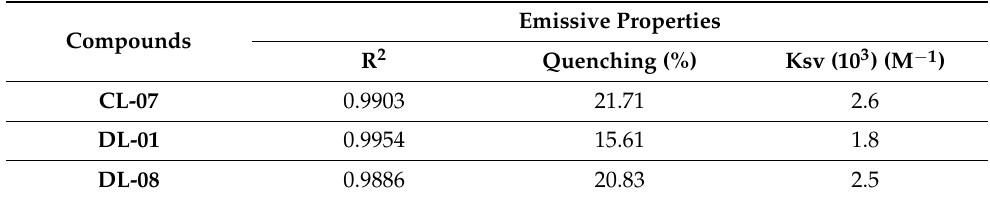
Table 5. Emissive properties of derivatives in the presence of CT DNA–EtBr.